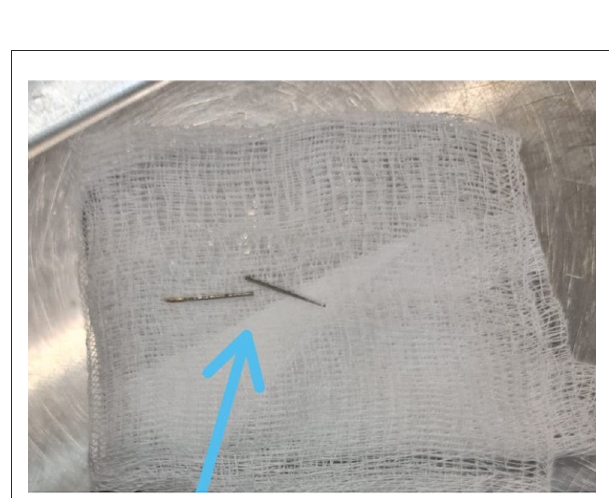
FIGURE5 The blue arrow points to the 2 metallic objects retrieved in surgery that penetrated the dura and were partially lodged in the parenchyma of the brainstem. Each measured ∼ 20mm (0.75 inches) in